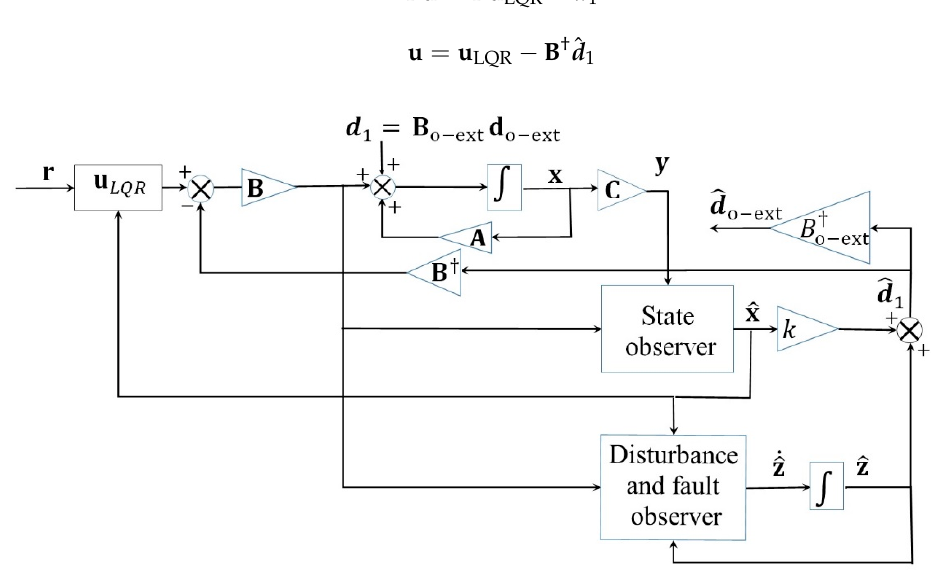
Figure 4. Block diagram of the disturbance and fault rejection AVOECR-LQR control loop.